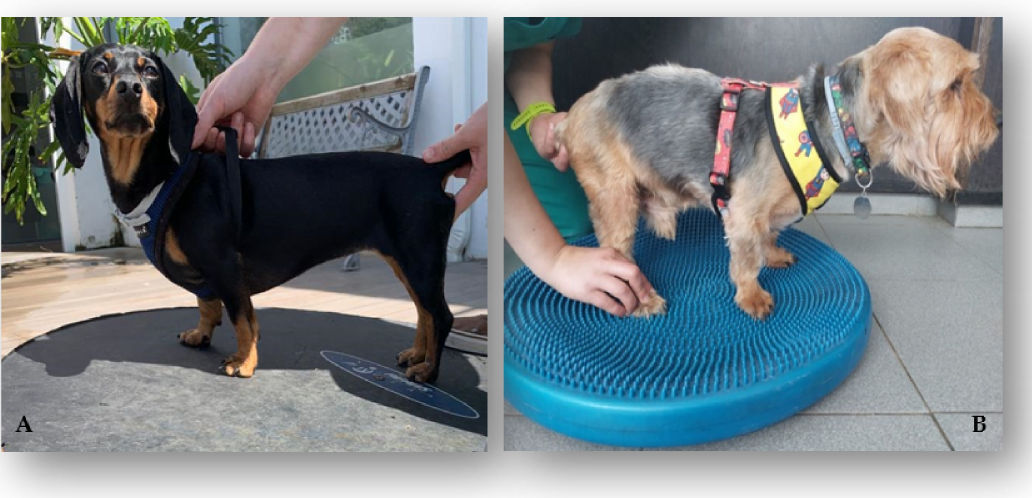
Figure 7. Kinesiotherapy exercises. ( A ) Postural standing on a balance board; ( B ) bicycle movements on a central stimulation pad.